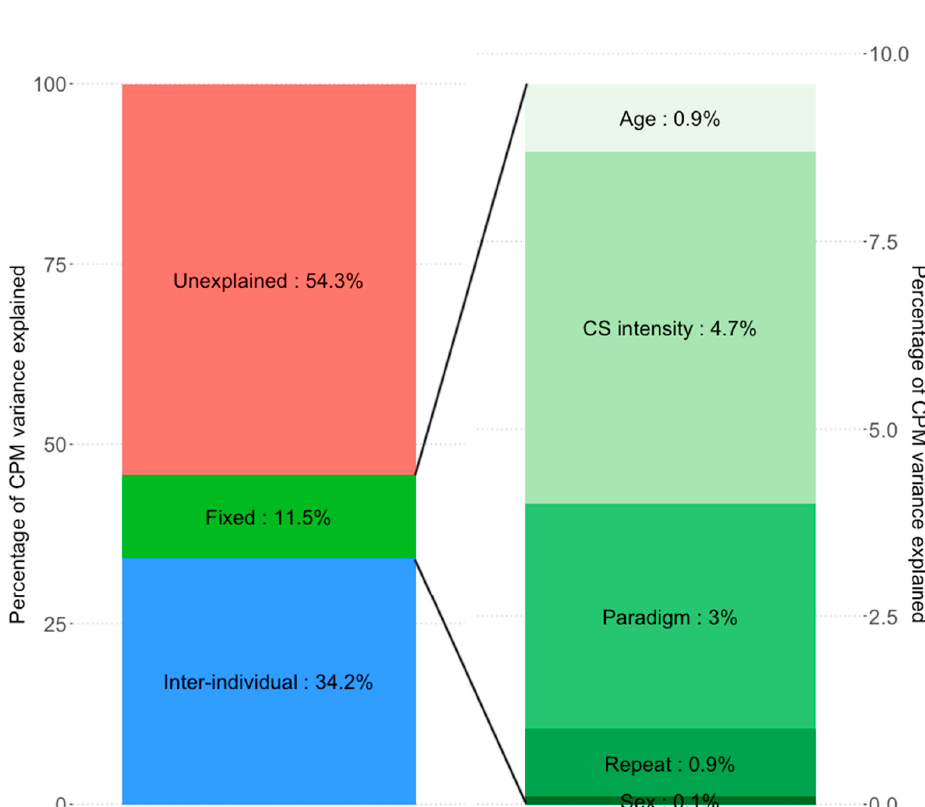
Figure 2. Proportions of variance in CPM explained by the CS physical intensity models (models 4 and 6) . Inter-individual differences explain substantially more CPM variance than the fixed effects of age, sex, CS intensity or the nuisance regressors CPM paradigm or measurement repeat (34.2% vs. 11.5%, respectively). Of the fixed effects, CS intensity explains the most variance (4.65%), followed by CPM paradigm (3.01%). Age (0.89%), Sex (0.09%), and measurement repeat (0.87%) explain negligible amounts. Due to different model types (model 4: linear mixed effects model; Model 6: multiple linear regression model) and different statistical methods needed to estimate partial variance explained, the sum of fixed effects variance explained in Model 6 does not equal exactly the estimated variance of combined fixed effects in Model